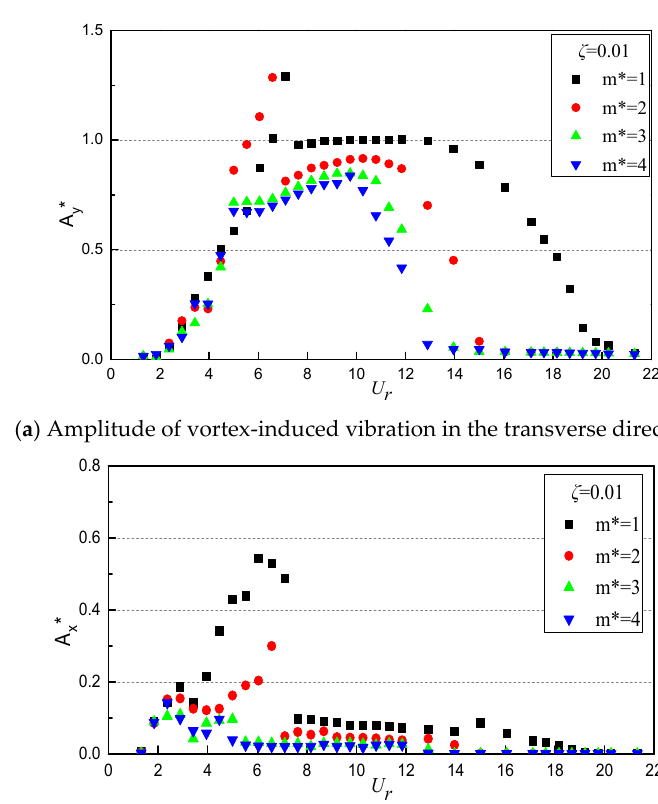
Figure 7. The variation in the amplitude of the dimensionless vortex-induced motion of the cylindrical oscillator under different mass ratios with Ur.